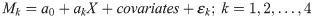
Mediation model for AA-NHW differences in heat pain tolerance.Note. Pain Catastrophizing (PC) partially mediated the association between AA-NHW differences in heat pain tolerance, indicating that AA-NHW differences in heat pain tolerance were partially explained by higher PC in AAs; HR/MAP index negatively mediated the association, indicating that lower HR/MAP index (higher baroreflex set point) in AAs partially suppressed AA-NHW differences in heat pain tolerance. Path values represent standardized beta coefficients (*p < .05). Full statistics are presented in Table 5. The models estimated in the Figure were:
Mk=a0+akX+covariates+εk;k=1,2,…,4
Y=b0+bkMk+c′X+covariates+ε;k=1,2,…,4
Where age, gender, BMI, study site, and education and income level were entered as covariates. The product of akbk represents the indirect effect for kth mediator and c’ the direct effect.